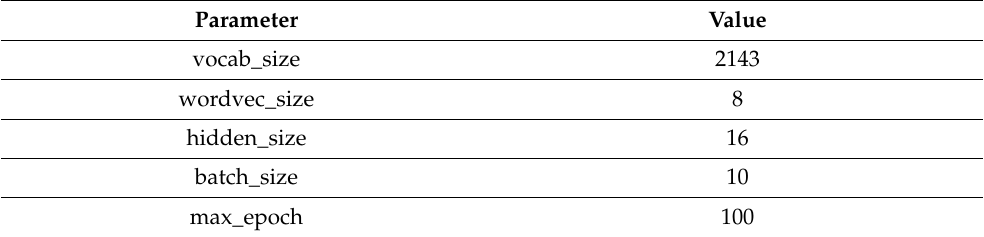
Table 1. Parameters of the proposed deep learning model.